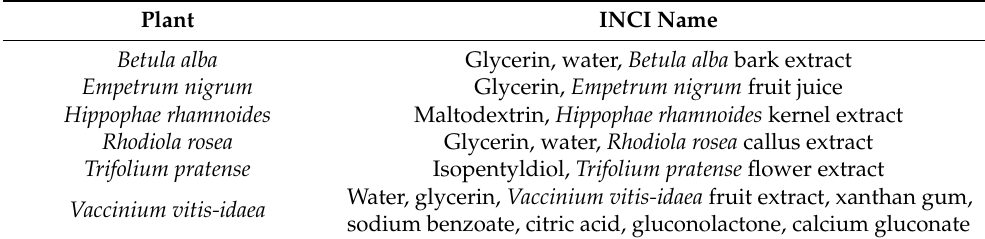
Table 4. List of the six extracts screened and their composition. Plant INCI Name Betula alba Glycerin, water, Betula alba bark extract Empetrum nigrum Glycerin, Empetrum nigrum fruit juice Hippophae rhamnoides Maltodextrin, Hippophae rhamnoides kernel extract Rhodiola rosea Glycerin, water, Rhodiola rosea callus extract Trifolium pratense Isopentyldiol, Trifolium pratense flower extract Vaccinium